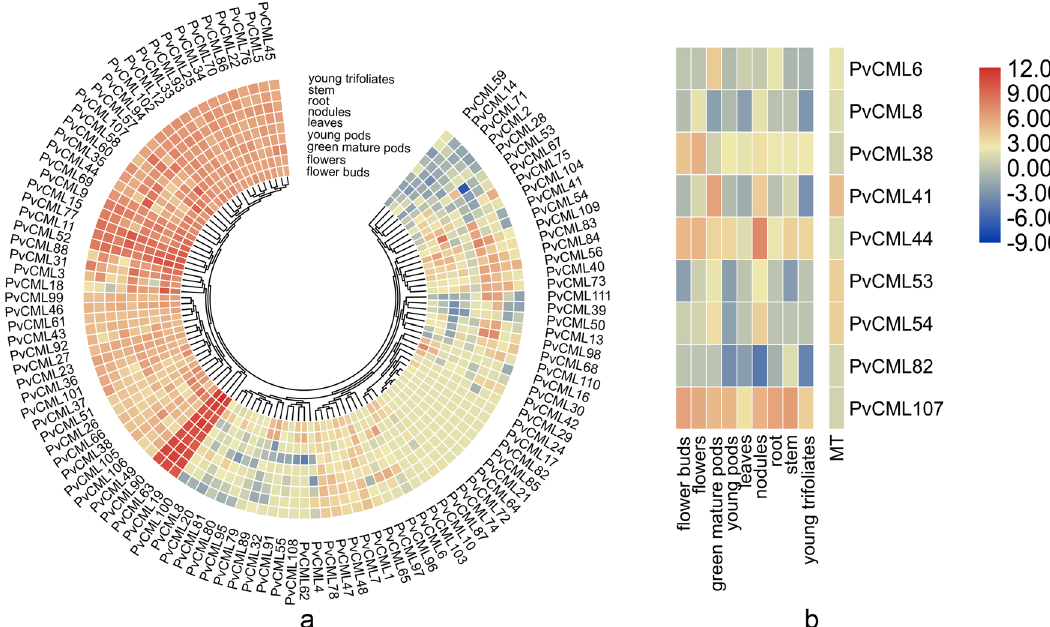
Figure 6. Transcriptome analysis of PvCML gene under different tissues and melatonin treatment. ( a ) Expression pattern of PvCML genes in different tissues based on the transcriptome data. ( b ) The expression profiles of PvCML genes in root after melatonin treatment. Transcript levels were depicted by different colors on the scale. Blue and red represented low and high expression levels, respectively.